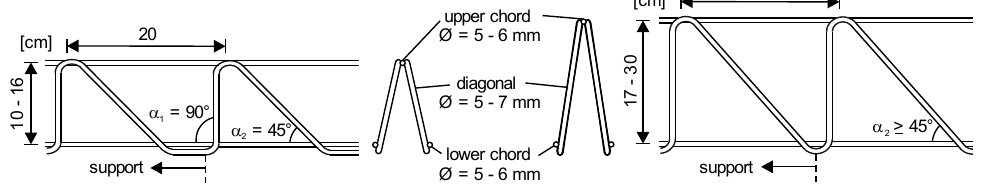
Figure 2. Geometries of lattice girder KTS /EQ according to [41,42].